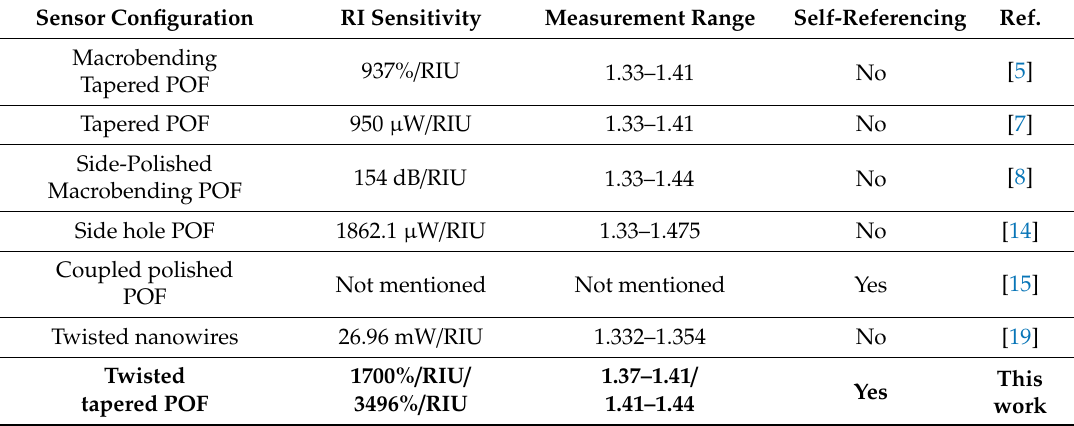
Table 5. Comparison of the performance of different RI sensors.